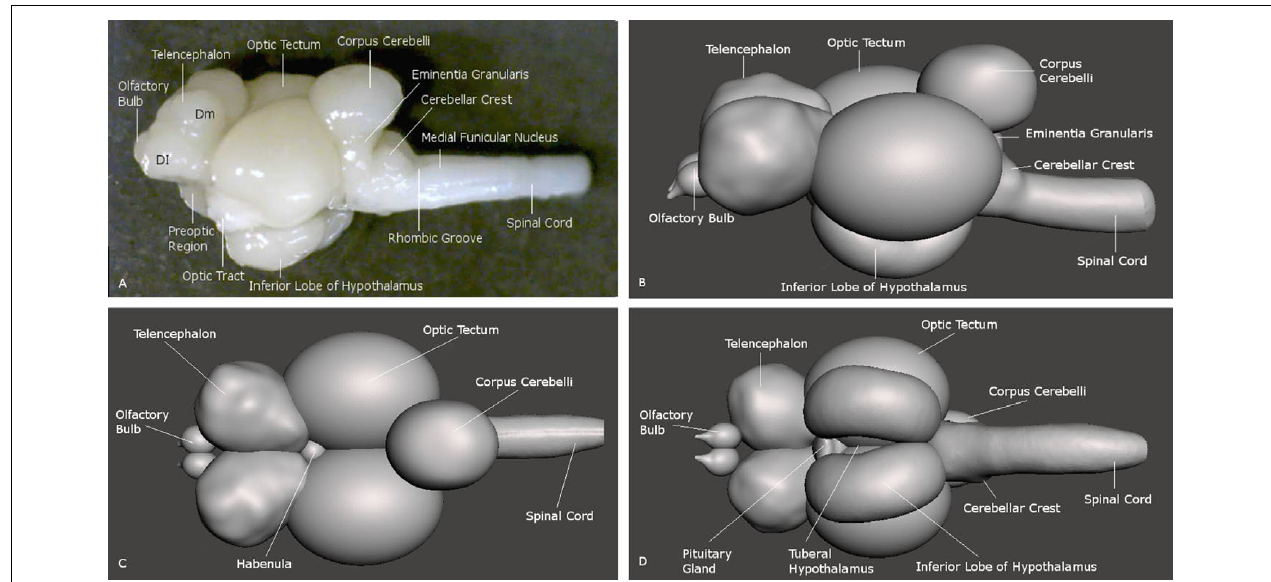
FIGURE 2 | Brain of the archerfish Toxotes chatareus shown in lateral view (A) and in reconstructions seen from lateral (B) , dorsal (C) , and ventral (D) . Dm medial zone of dorsal telencephalic area (pallium), Dl lateral zone of dorsal telencephalic area